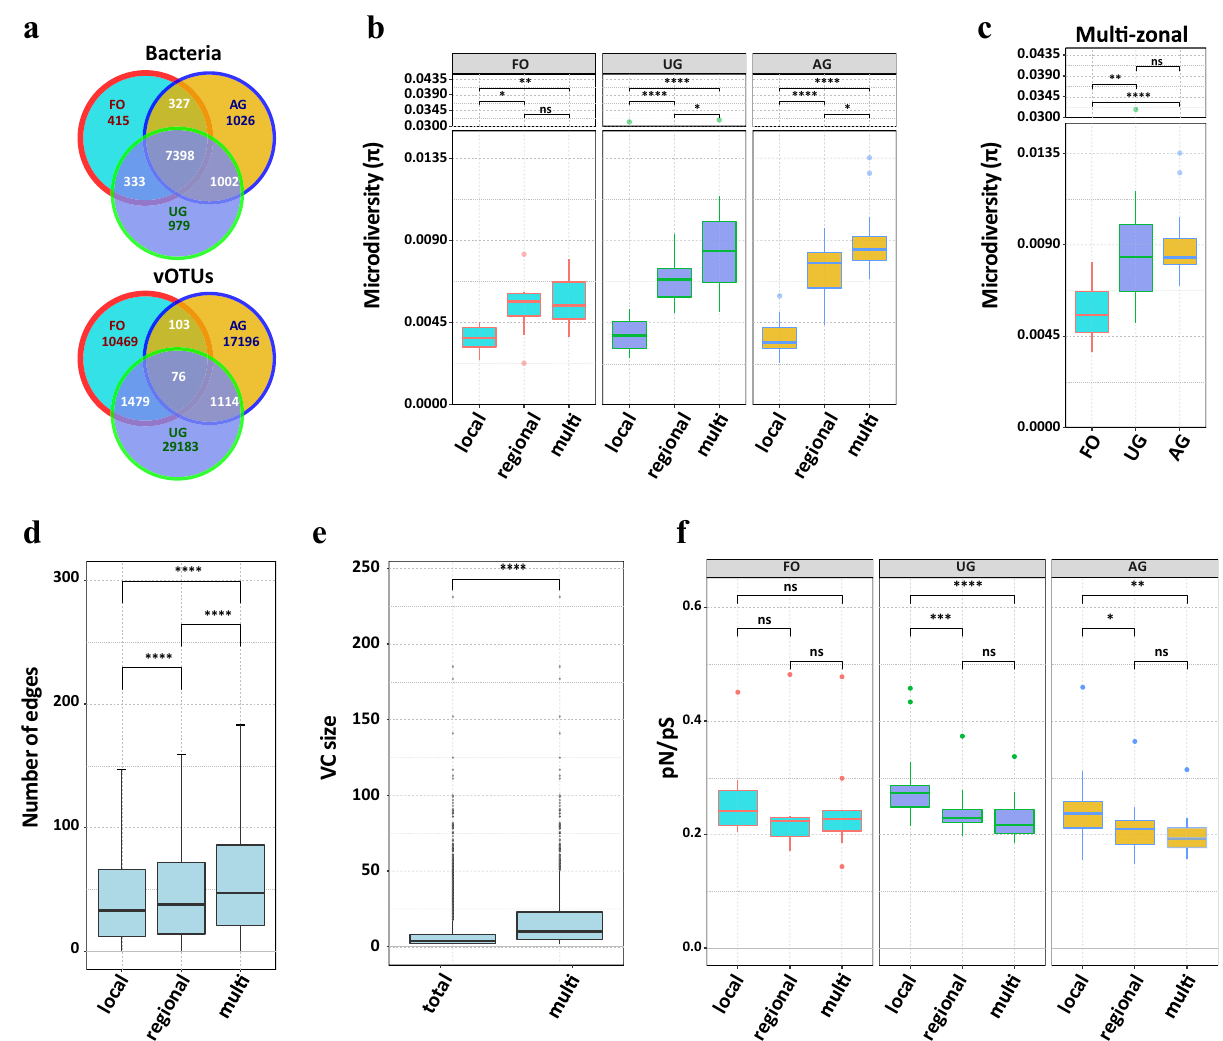
Fig. 6 | Evolutions of soil vOTUs with different geographic ranges. a Venn dia- gram showing the shared vOTUs (top) and bacterial species (bottom) among three land use zones. b The microdiversity of local, regional, and multi-zonal vOTUs in zones FO ( n =10), UG ( n =20) and AG ( n =20). c The microdiversity of multi-zonal vOTUs among three land use zones FO ( n =10), UG ( n =20) and AG ( n =20). d The connection number of local ( n =44,534), regional ( n =12,314), and multi-zonal ( n =2771) vOTUs in gene-sharing network. e The size of total VCs ( n =6009) and multi-zonal VCs ( n =1416). The exact p value less than 2.2e-